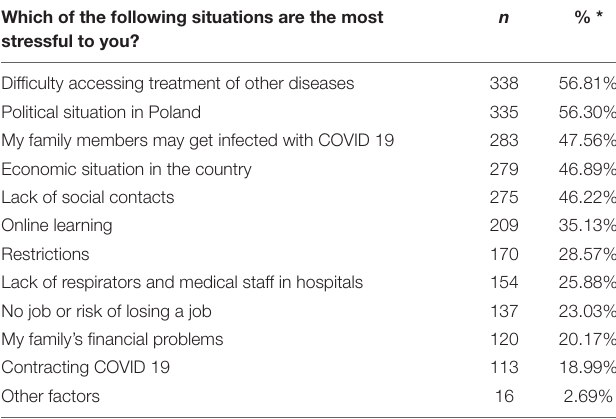
TABLE 1 | Source of stress during the pandemic according to the people